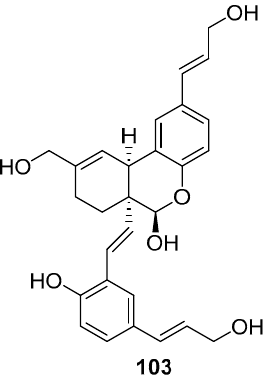
Figure 36. One of the coumarin derivatives isolated from M. exotica.